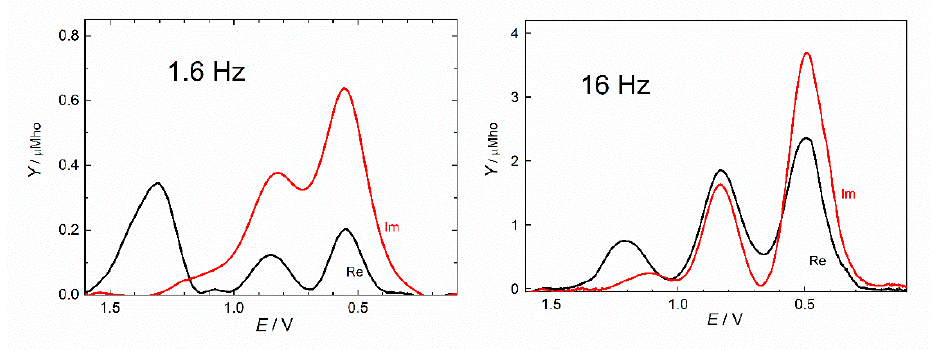
Figure 5. AC voltammogram at 1.6 Hz ( left ) and 16 Hz ( right ). The faradaic part of the admittance vector of 1 @AuNPs (DCE/Bu 4 NPF 6 ). The real (Re) and imaginary (Im) components are black and red curves, respectively.